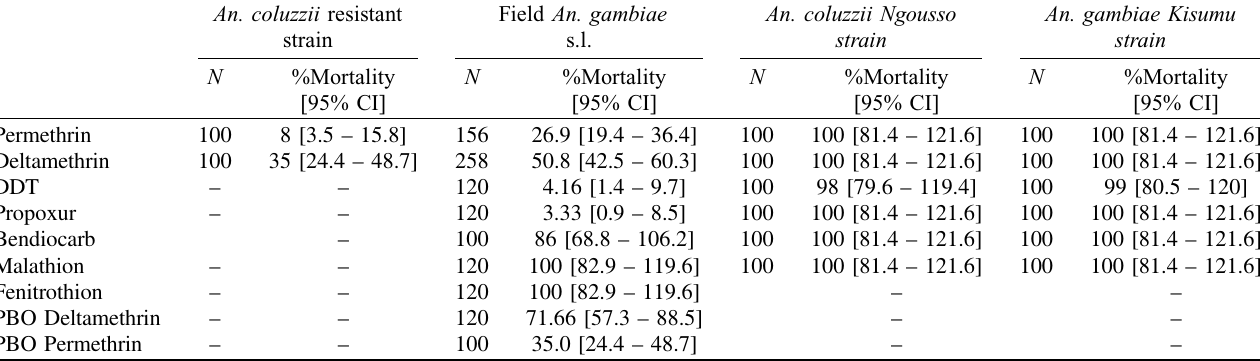
Table 1. Mortality rate of Anopheles gambiae s.l. from Yaoundé exposed to certain